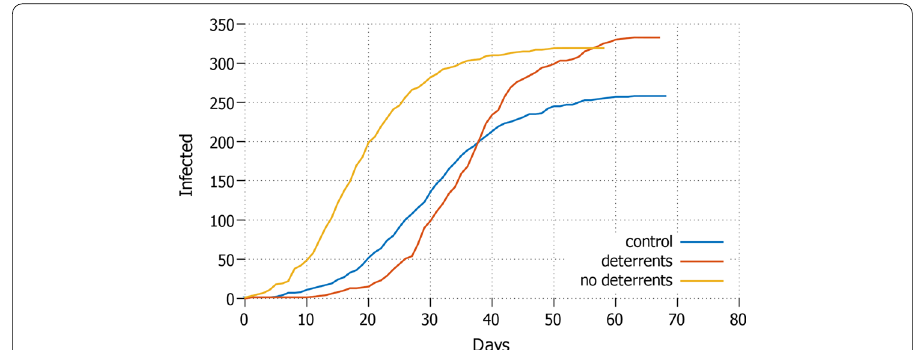
Fig. 5 Student Daily increment with students in lockdown and protective measures applied